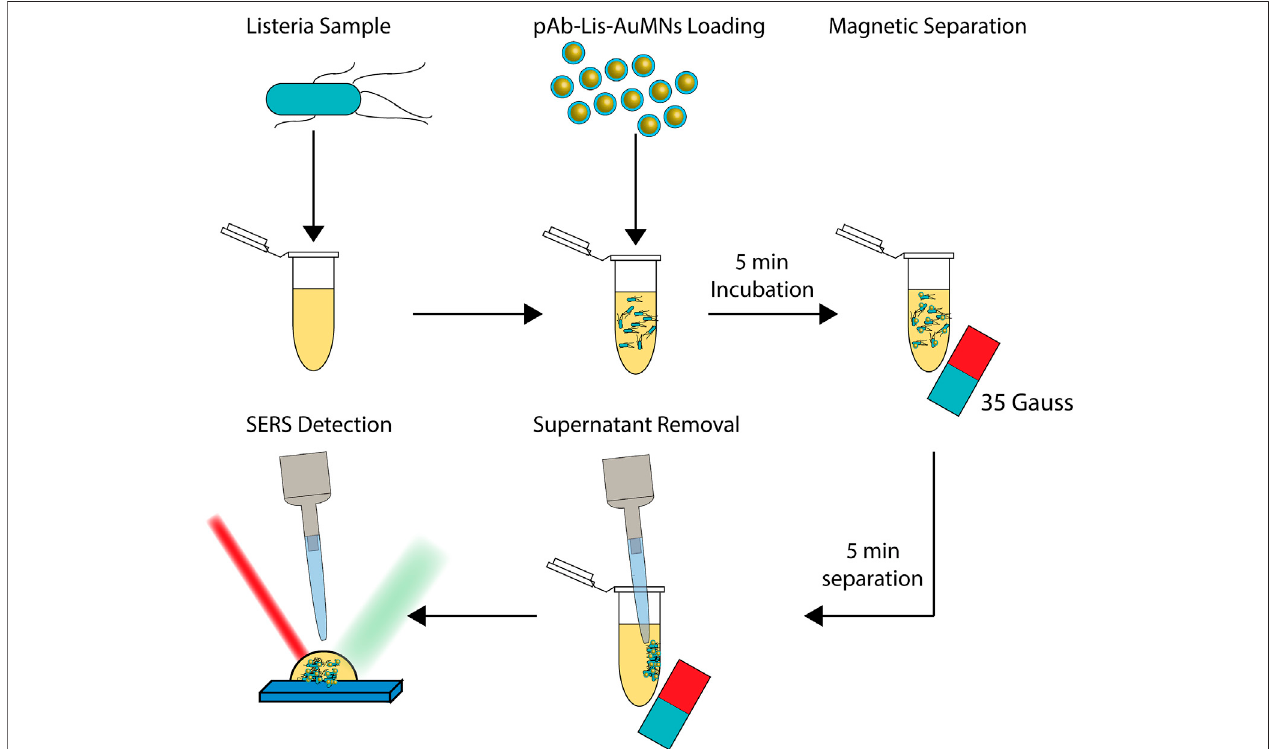
FIGURE2| GraphicaldepictionofSERSenrichment-enhancementmethod. Listeria ofadesiredconcentration iscollected. Listeriamonocytogenes targetingpAb are bound to AuMNs and added to the L. monocytogenes sample before incubating for a short time. The L. monocytogenes now bound with pAb-Lis-AuMNs are aggregated using a 35 Gauss magnet. Supernatant is then carefully removed before using the enriched sample in the SERS detection. Binding, separation, and detection of L. monocytogenes occurs in less than 15 min.